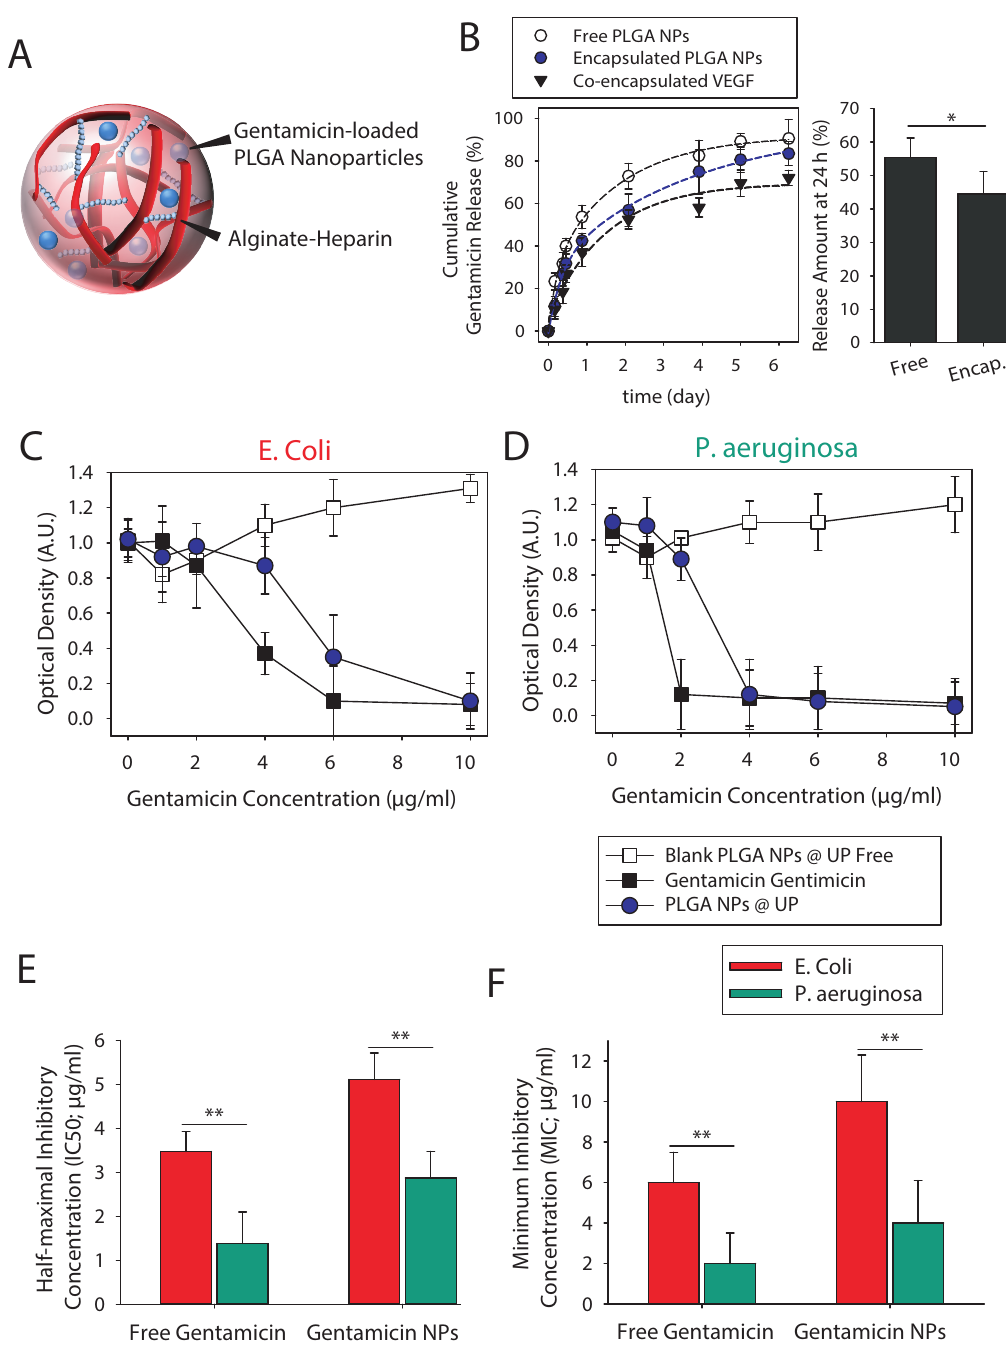
Figure 5. Evaluation of gentamicin release. ( A ) Gentamicin-loaded poly(lactic-co-glycolic) acid (PLGA) nanoparticles (NPs) encapsulated in alginate-heparin microparticles. Estimated amount of released gentamicin after 24 h. ( B ) Cumulative release profiles of gentamicin from free PLGA NPs and from microparticle-encapsulated PLGA NPs. Cumulative release profiles of co-encapsulated VEGF from alginate-heparin microparticles are also shown here. Analysis of the ability of gentamicin PLGA NPs to inhibit the growth of ( C ) Escherichia coli and ( D ) Pseudomonas aeruginosa as determined by measurement of absorbance at 600 nm. Estimated ( E ) half-maximal inhibitory (IC50) and ( F ) minimum inhibitory concentrations (MIC) values for free and PLGA-encapsulated PLGA NPs (average ± SD, n = 3). * and ** indicate significant di ff erence of p < 0.05 and p < 0.01, respectively, as evaluated by one-way ANOVA. The lines in the graphs are a guide for the